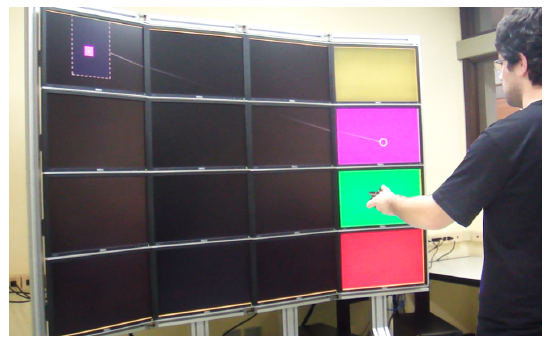
Figure 8. LOP-Cursor